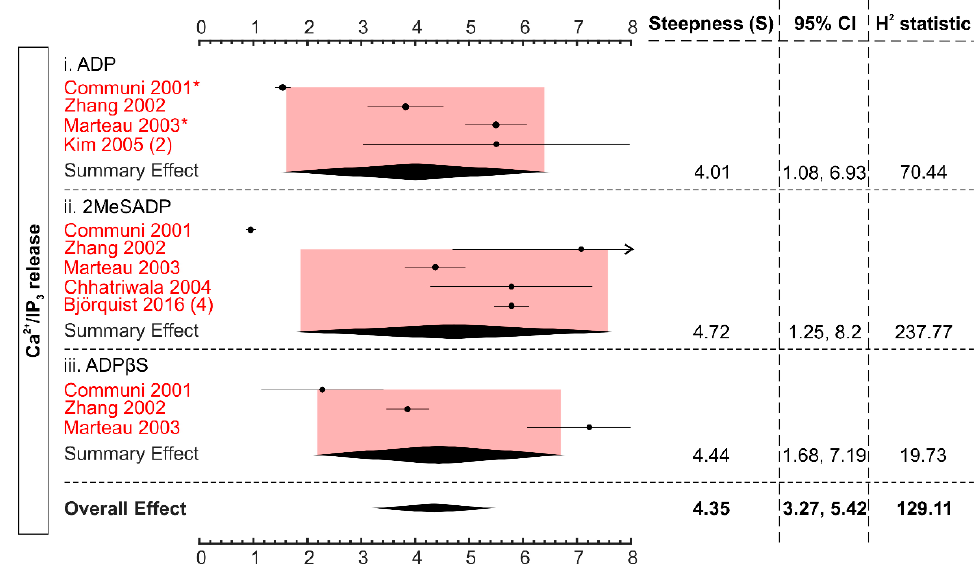
Figure 4. Steepness (S) in Ca 2+ /IP 3 release dataset. The steepness of slope (S) was assessed in the largest signaling dataset, Ca 2+ /IP 3 release. The black diamond represents the overall effect size, and the pink shaded region represents the 95% confidence interval. The study names marked in “red” were conducted in the heterologously-expressed P2Y13 receptor. All the studies were of sample size, n = 3, unless otherwise stated in parentheses. The studies marked in * had multiple datasets of the same agonist and outcome in the individual study and were averaged, with Communi et al., 2001, having 2 datasets and Marteau et al. 2003 having 3 datasets.